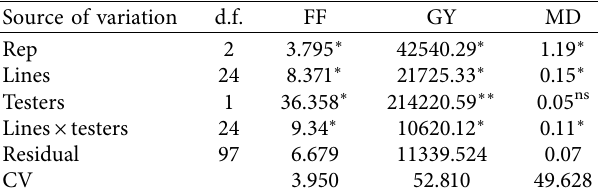
Table 2: Mean performance of 50 experimental hybrids evaluated in the 2015 rainy